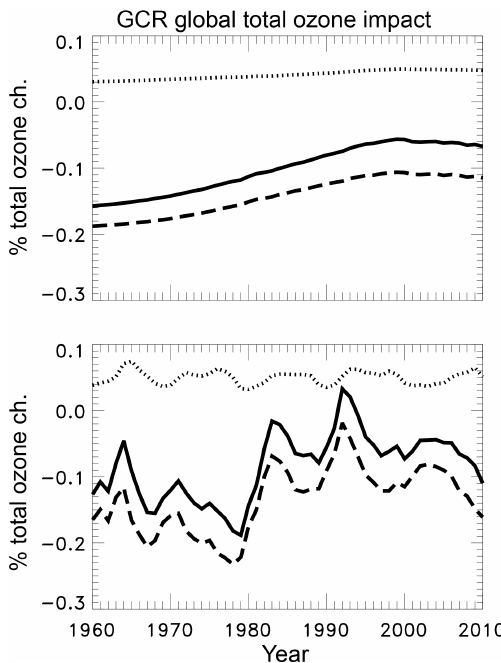
Figure 8. GSFC 2-D model GCR-computed impacts of AAGTO between 1000 and 100hPa (dotted black), between 100 and 1hPa (dashed black), and for the entire troposphere and stratosphere, 1000 to 1hPa, (solid black) over the 1960–2010 time period. The top plot shows the comparison of simulation A1_GCR_GSFC to A_Base_GSFC . The bottom plot shows the comparison of simu- lation E_GCR_GSFC to E_Base_GSFC .